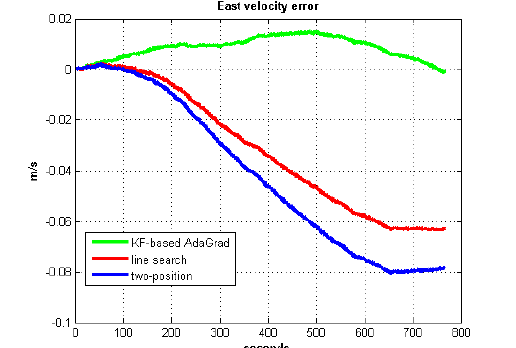
Figure 21. East velocity error in test 2.